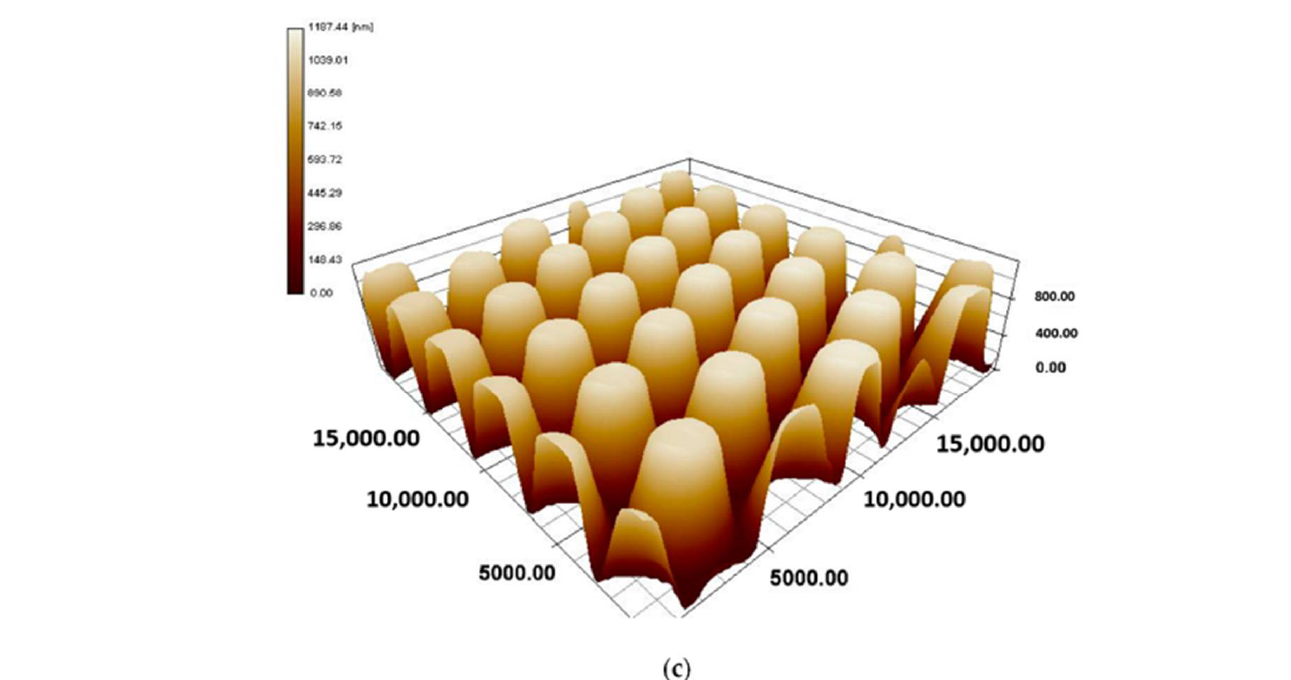
Figure 1. The BOPET film mold; ( a ) the AFM image; ( b ) the profiles; ( c ) a 3-dimensional AFM topography image.